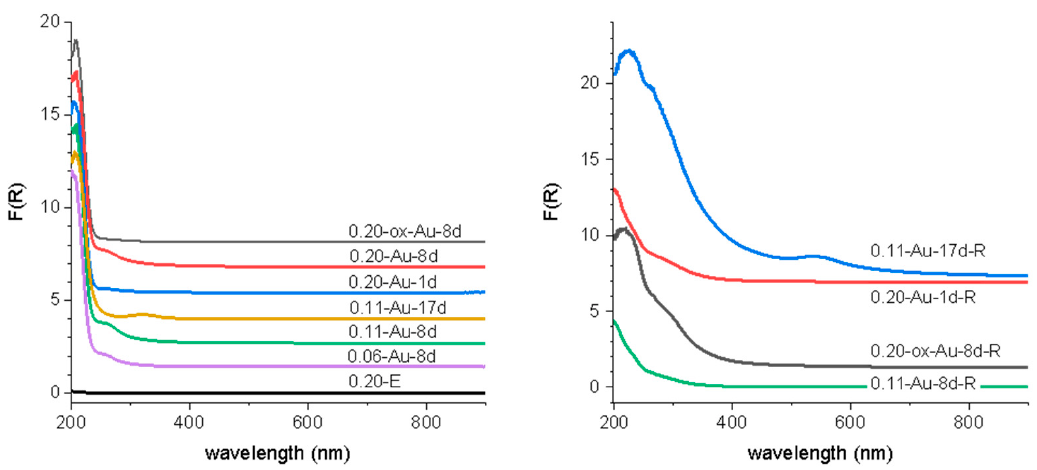
Figure 4. UV-Vis spectra of Au-containing SBA-15 materials and parent extracted SBA-15 ( left ) and selected spent catalysts ( right ).